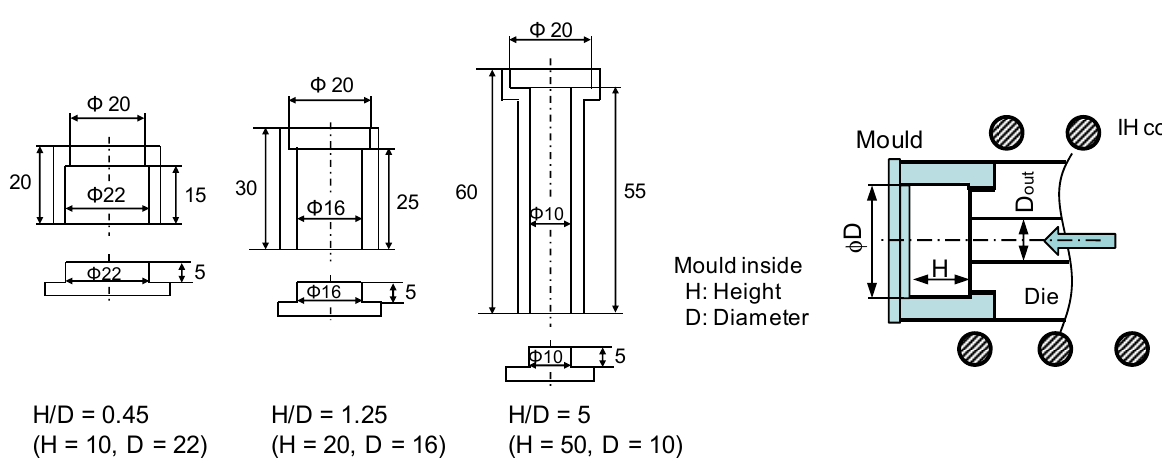
Figure 4. Shape and size of mold.